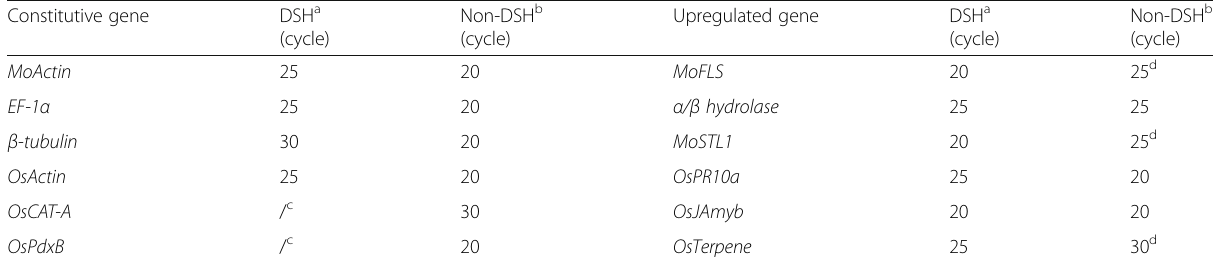
Table 1 The cycle numbers of clearly visible amplification products of constitutive and upregulated genes Constitutive